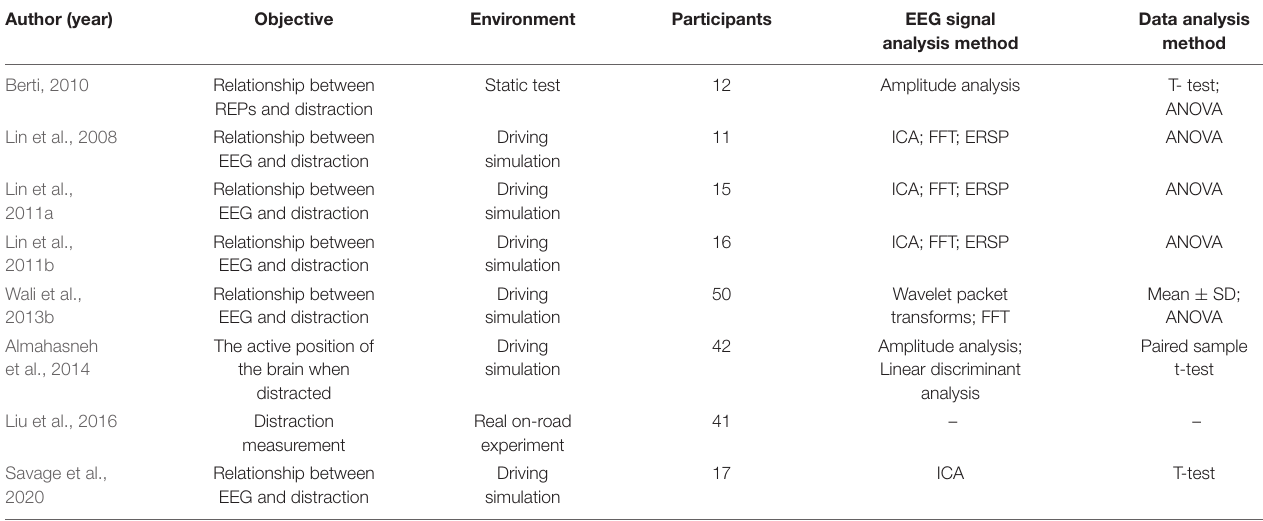
TABLE 2 | Research summary of distracted driving based on